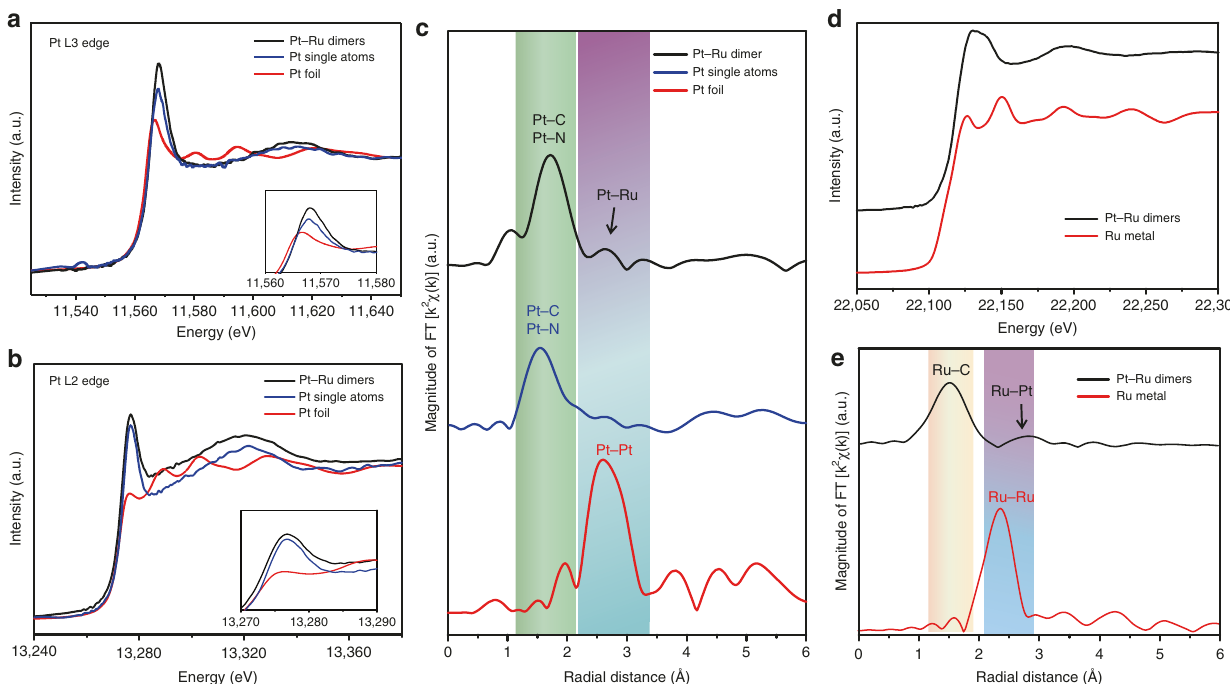
Fig. 3 X-ray absorption studies of the Pt – Ru dimers, Pt single atoms and Pt foil. a , b The normalized XANES spectra at the Pt L3-edge and L2-edge of the Pt – Ru dimers, Pt single atoms and Pt foil. c corresponding K2-weighted magnitude of Fourier transform spectra from EXAFS of the Pt – Ru dimers, Pt single atoms and Pt foil. d The normalized XANES spectra at the Ru K-edge and e corresponding K2-weighted magnitude of Fourier transform spectra from EXAFS of the Pt – Ru dimers and Ru metal